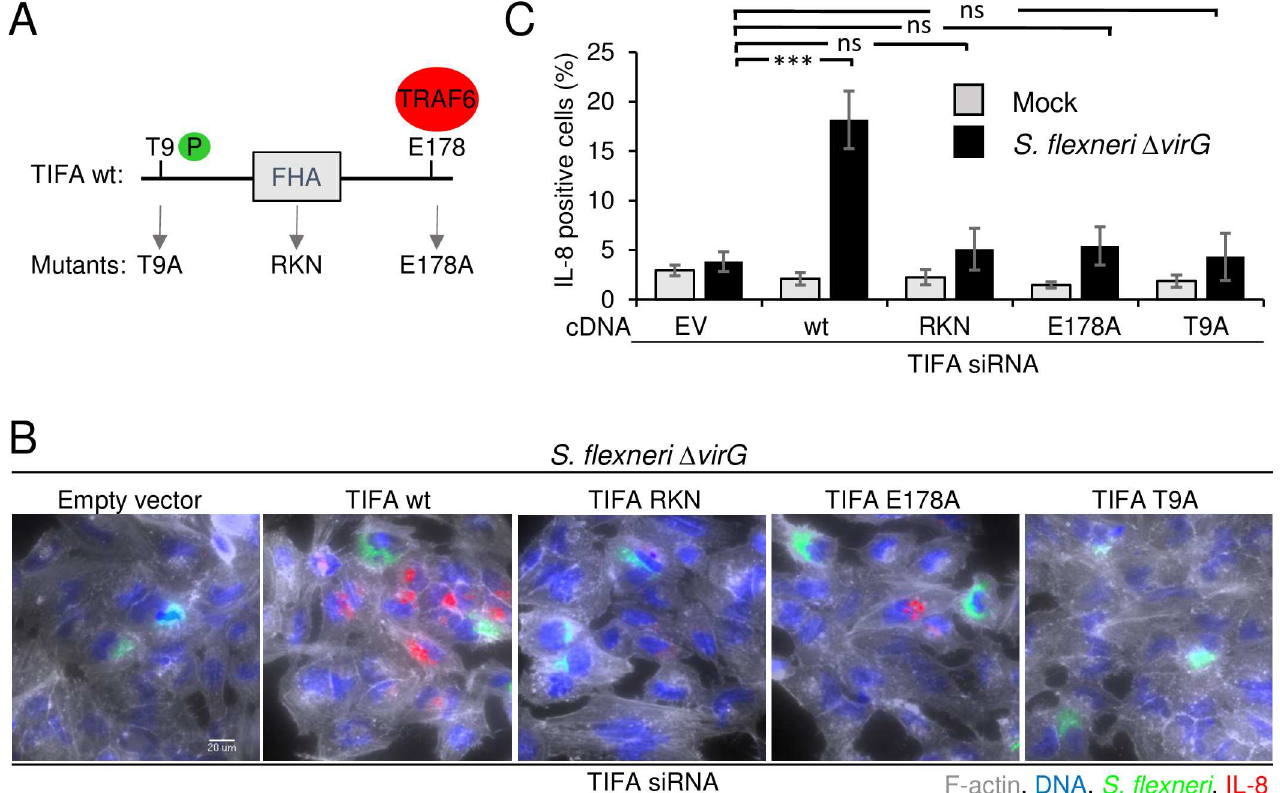
Fig 3. Residue T9, the FHA domain and residue E178 of TIFA are necessary for IL-8 expression. A) Schematicrepresentation of wild-type TIFA and the T9, RKN and E178A TIFA mutants. B ) Only wild-typeTIFA rescues IL-8 expressionafter siRNA-mediateddepletionof TIFA. HeLa cells were transfected for 72 hours with TIFA-targeting siRNA. 24 hours prior infection, cells were transfected with empty vector, wild-typeor mutated TIFA cDNA constructs. All TIFA cDNA constructs are TIFA siRNA-resistant. Cells were infected with S . flexneri Δ virG (green)for 3.5 hours. After fixation, cells were stained for F-actin (grey), DNA (blue) and IL-8 (red). Scale bars, 20 μ m. C ) Quantification of IL-8 as shown in B. Data correspondto the mean +/- SD of 3 independent experiments, p *** < 0.0005, ns: non-significant p >